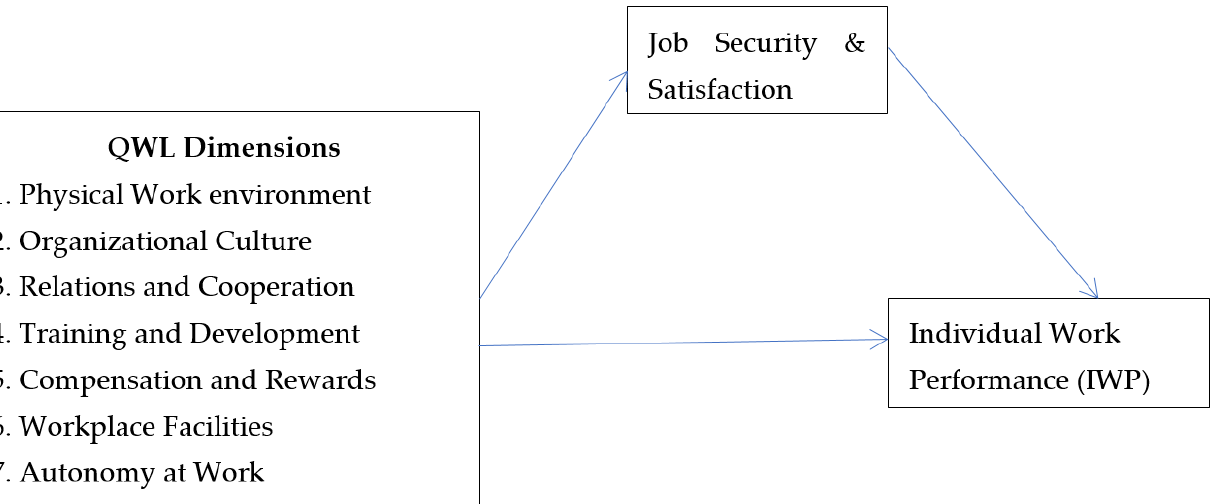
Figure 1. Impact of QWL on job security and satisfaction and individual work performance; source: Din et al. (2018).